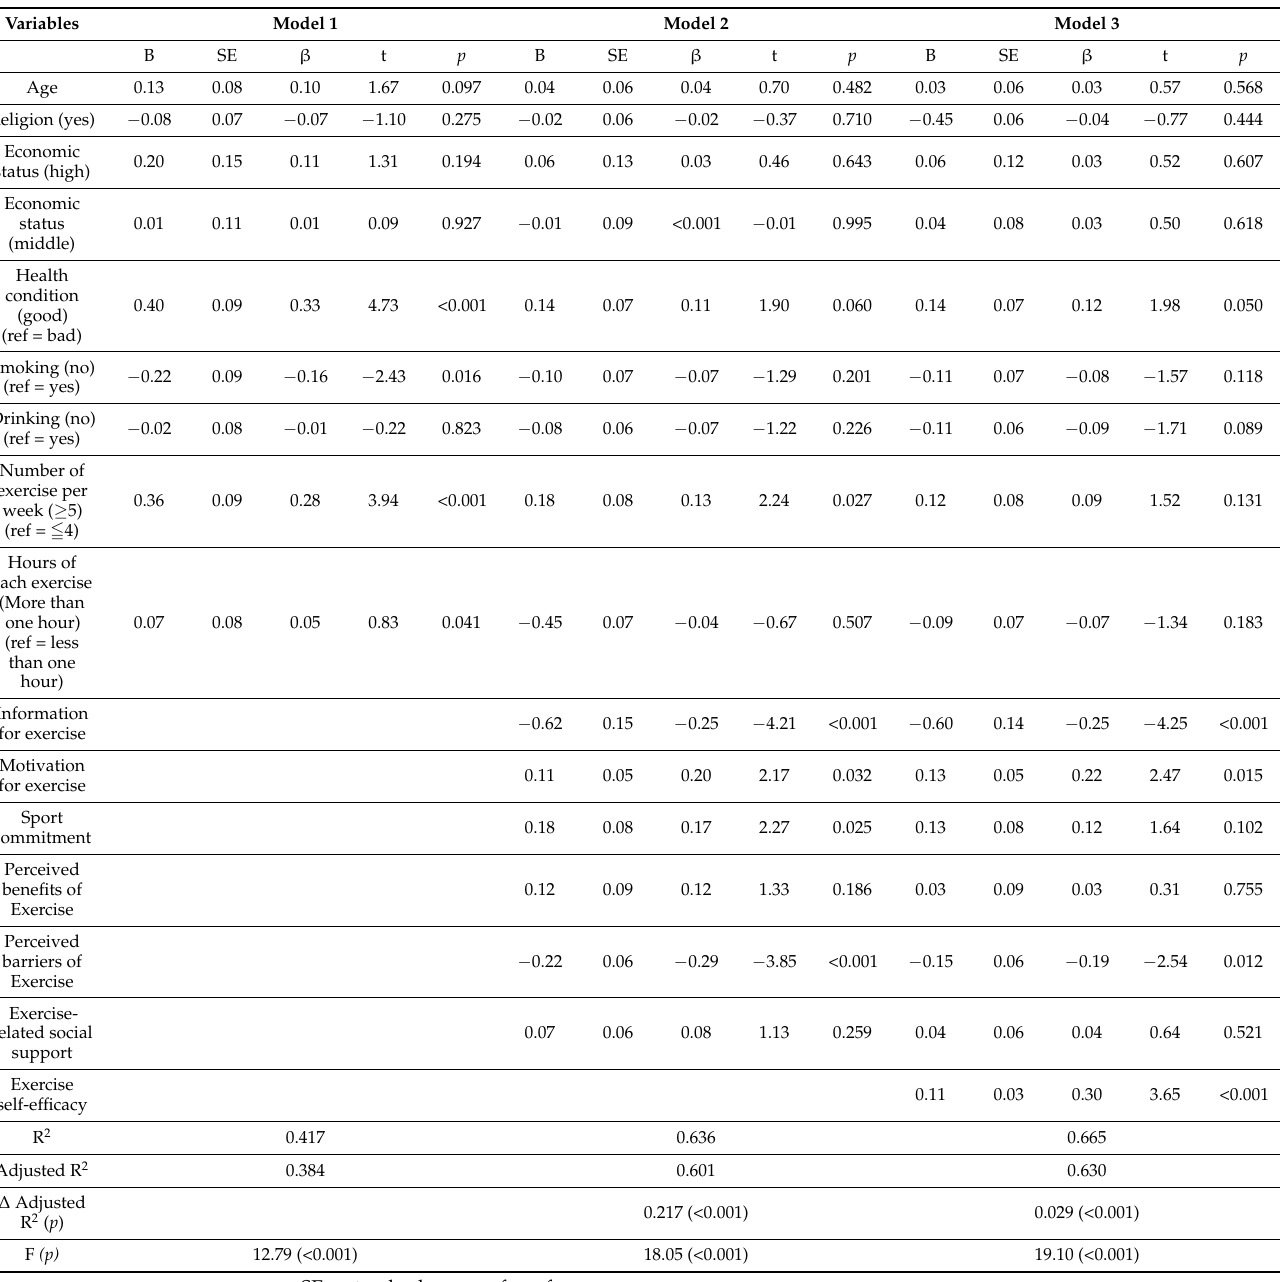
Table 4. Factors affecting the performance of exercise behavior of middle-aged